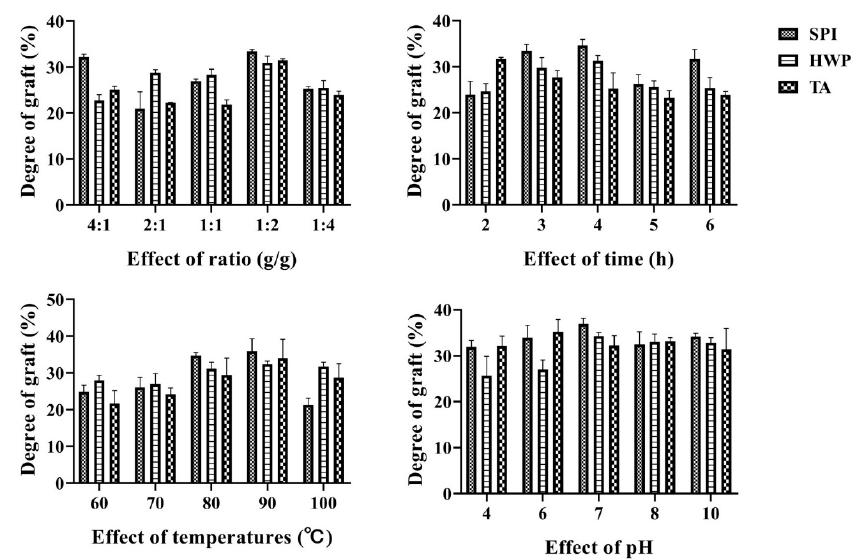
Figure 1. Grafting degree of complex under di ff erent treatment